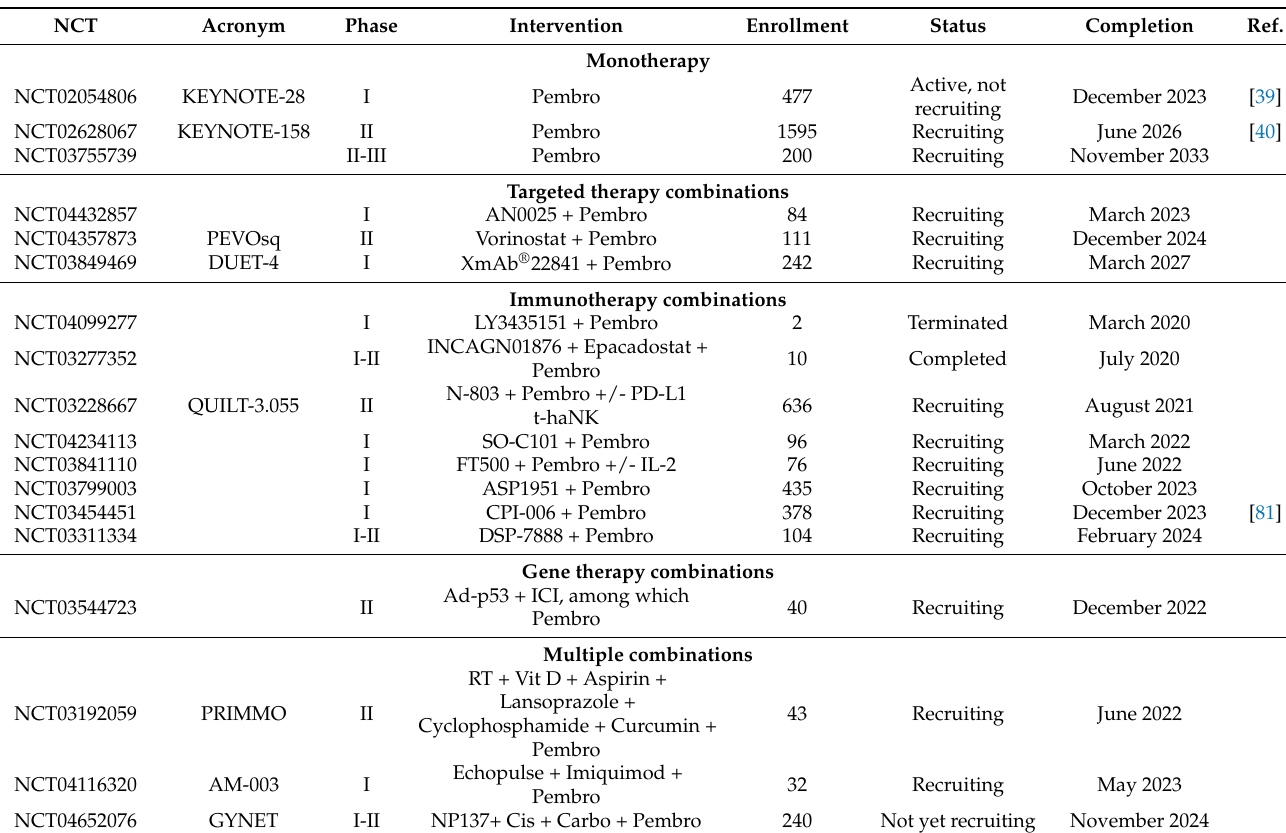
Table 3. Current clinical trials assessing pembrolizumab in multiple malignancies, among which cervical cancer.